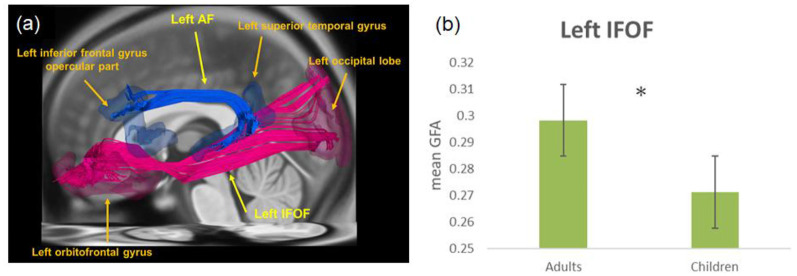
(A) The left inferior frontal-occipital fasciculus (IFOF), the arcuate fasciculus (AF), and their corresponding terminal regions in tractography, i.e., the left orbitofrontal gyrus and left occipital lobe for IFOF, as well as the left inferior frontal gyrus (IFG) opercular part and the left superior temporal gyrus (STG) for AF. The left ventral pathway connects the ventral IFG, middle temporal gyrus (MTG), and fusiform gyrus (FG; not shown) via IFOF. (B) The mean generalized fractional anisotropy (GFA) of IFOF in adults was significantly higher than that in children. *p < 0.05.